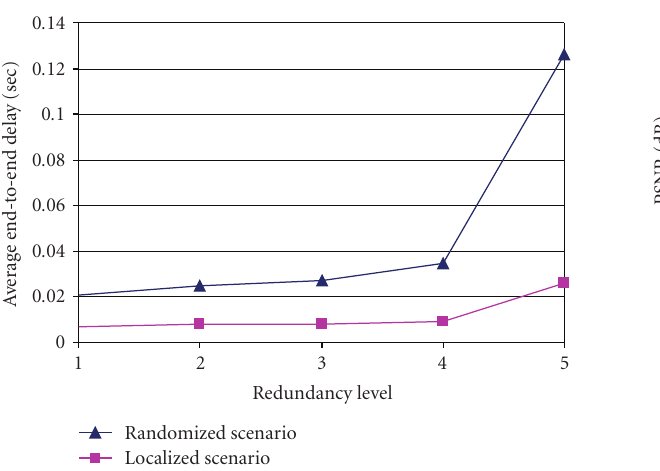
Figure 10: Avg. E2E Delay—Moderately loaded.